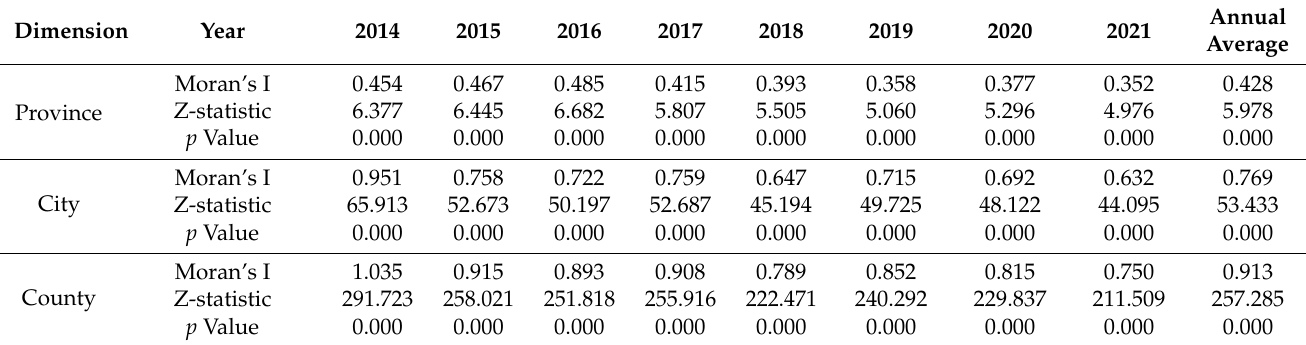
Table 2. Global Moran’s I Calculation Results from 2014 to